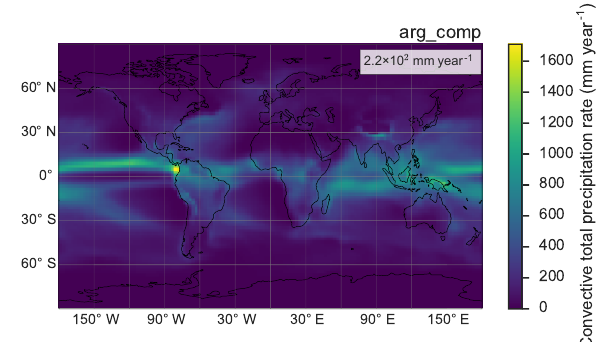
Figure 10. Annual average convective precipitation rate in the present-day arg_comp